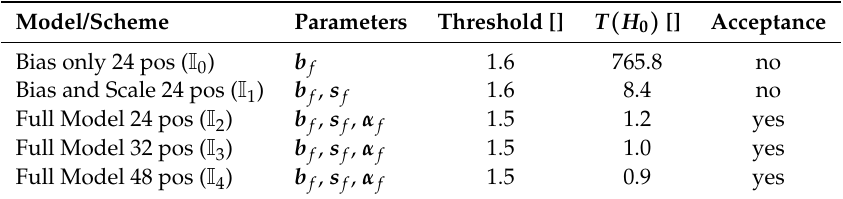
Table 5. Global test of adjustment for different sensor models.